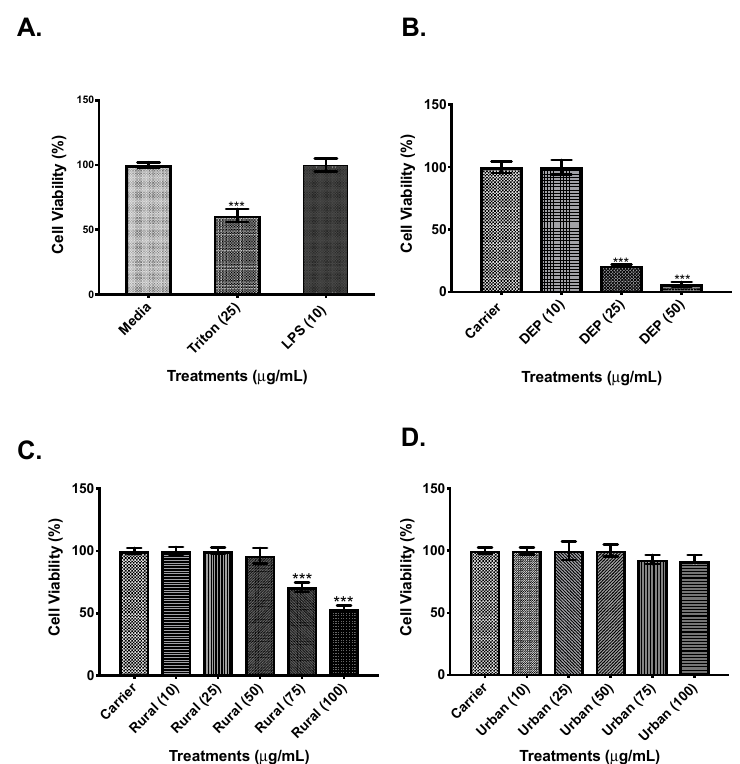
Figure 2. Cell viability. A total of 1.0 × 10 5 BEAS-2B cells were exposed for 24 h to various treatments prior determination of their viability using the Neutral Red Assay. ( A ). Control cells were exposed to KGM-2 media alone (Medium), 25 µg/mL of TRITON X-100, and 10 µg/mL LPS. ( B ). Cells were exposed to 0.1% of DMSO diluted in media (carrier) and increasing concentrations of DEP organic extract. ( C ). Cells were exposed to different concentrations of the rural airborne particulate matter (PM) organic extract. ( D ). Cells were exposed to different concentrations of the urban PM organic extracts. Values are expressed as the mean ± SEM ( n = 3), *** p ≤ 0.001 compared to media and to carrier (controls), when exposed to DEP organic extract, Rural PM organic extract, and Urban PM organic extract.